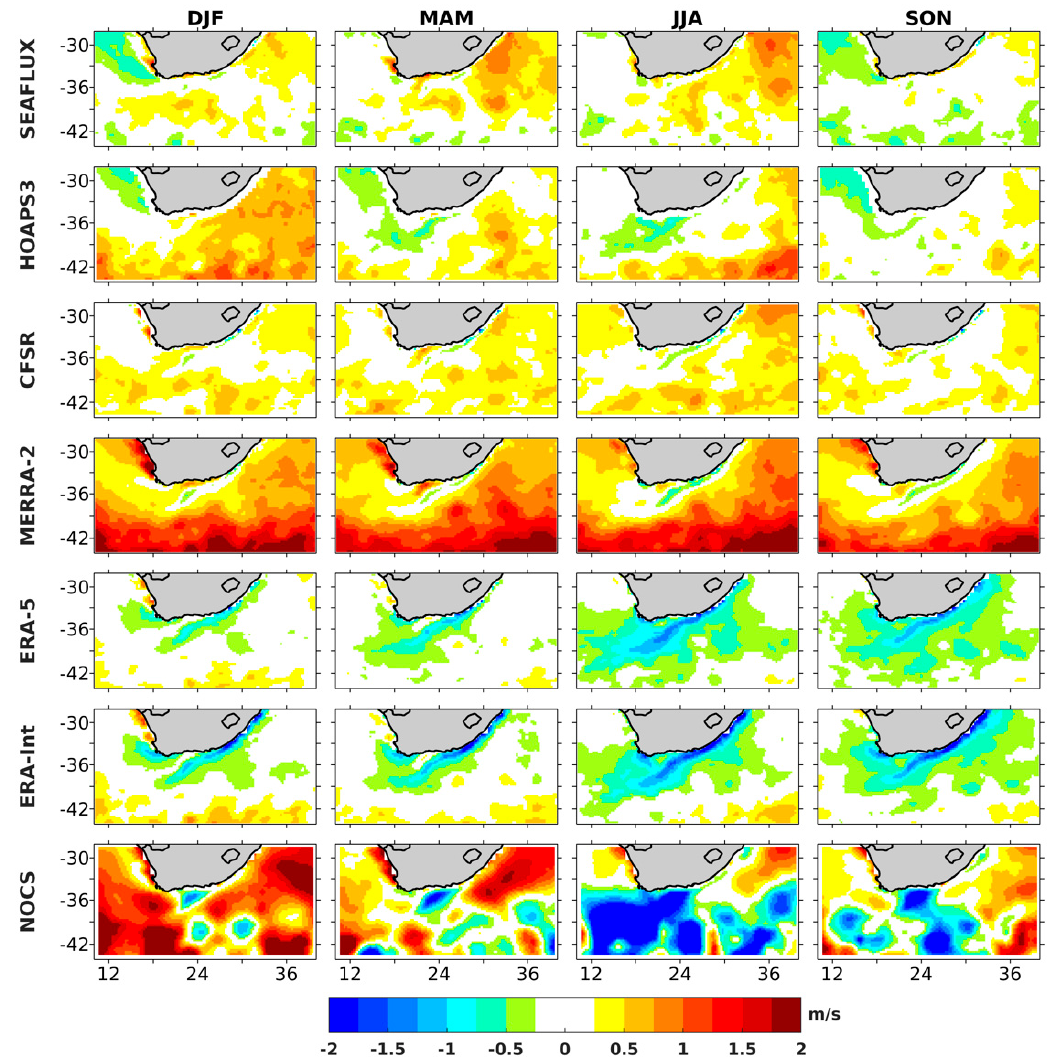
Figure 10 : Mean seasonal differences of surface wind speed (m/s) between the observation-based, the reanalysis products and SCOW. From left to right austral summer (DJF), austral autumn (MAM), austral winter (JJA) and austral spring (SON).